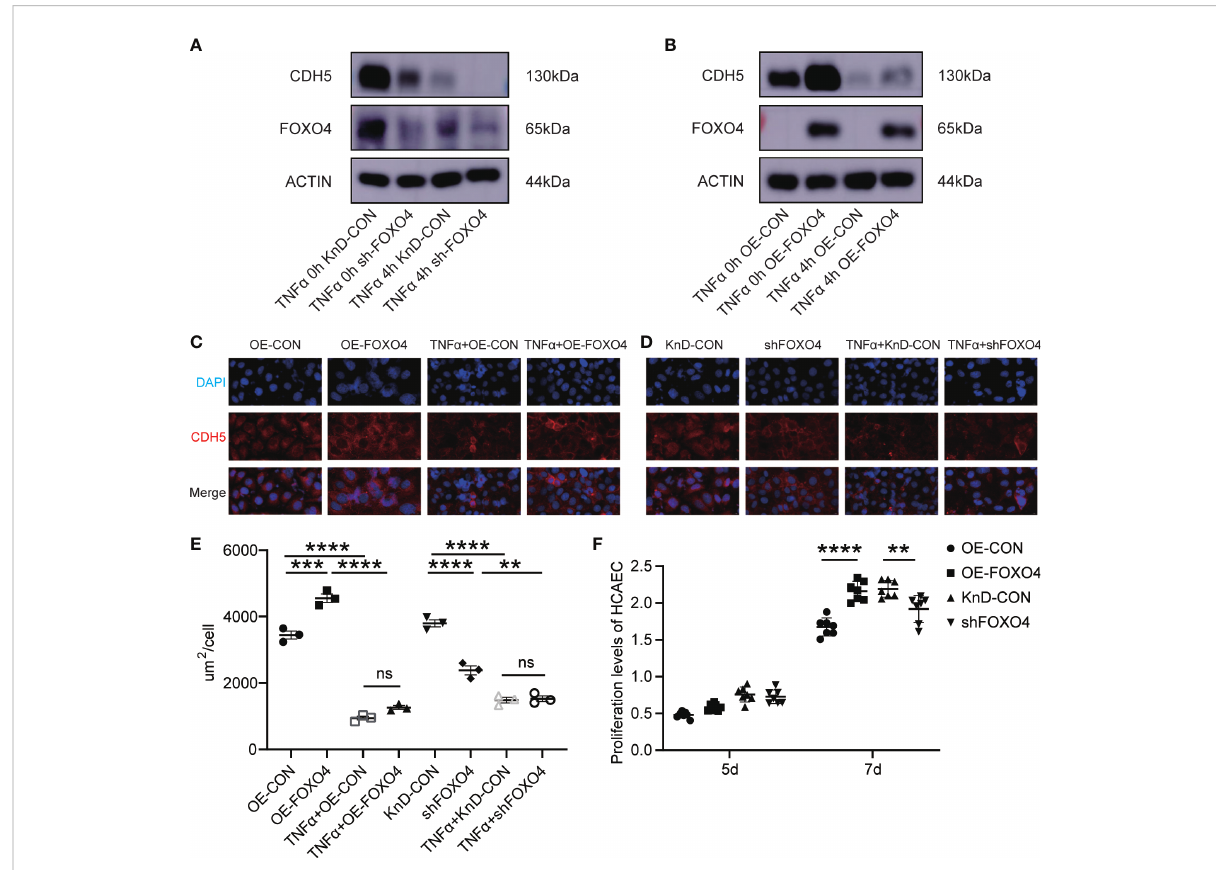
FIGURE 4 FOXO4 stabilized endothelial cell homeostasis in vitro . (A) HCAECs transfected with lentiviruses to knockdown FOXO4 lentiviral (shFOXO4) and their corresponding controls (KnD-CON) were stimulated with/without TNF a (40 ng/ml) for 4 hours. CDH5 and FOXO4 levels were analyzed. The loading control was b -Actin. (B) HCAECs transfected with lentiviruses overexpressing FOXO4 (OE- FOXO4) and their corresponding controls (OE-CON) were stimulated with/without TNF a (40 ng/ml) for 4 hours. CDH5 and NFAT2 protein level were analyzed. The loading control was b -Actin. (C-E) CDH5 expression was detected using immuno fl uorescence. FOXO4 overexpression (C) and knockdown (D) vectors and their corresponding controls were transfected into HCAECs, respectively. After 7 days, cells were stimulated with/without TNF a (40 ng/ml) for 4 hours. The cells were then immunostained with rabbit anti- CDH5, followed by staining with 594 goat anti-rabbit IgG (red). Cell nuclei were stained with DAPI (blue) and the fl uorescent images were captured. The immuno fl uorescence area per cell in the different groups (n = 3) (E) . (F) FOXO4 overexpression and knockdown vectors and their corresponding controls were transfected into HCAECs, respectively. After 5 days and 7 days, CCKL8 assays were used to detect HCAEC proliferation (n = 7). Data are presented as the mean ± SEM. Quantitative data were analyzed using one-way ANOVA (E, F) , **P < 0.01, ***P < 0.001, ****P <